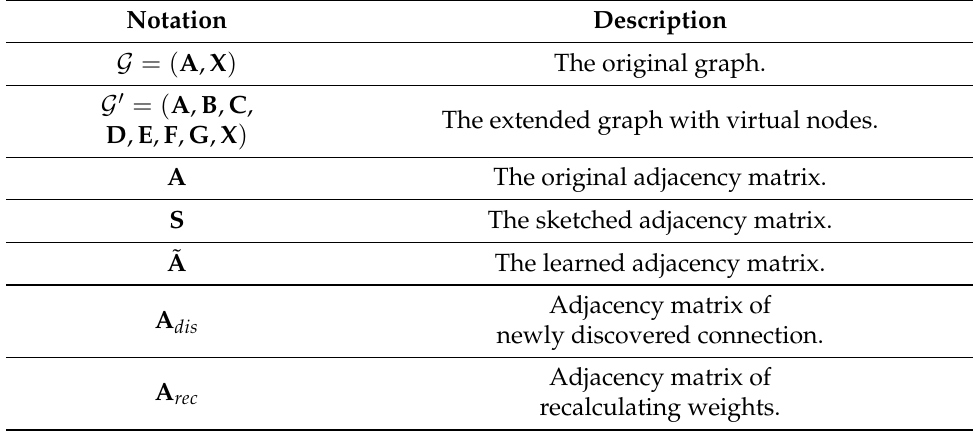
Table A1. Frequently used